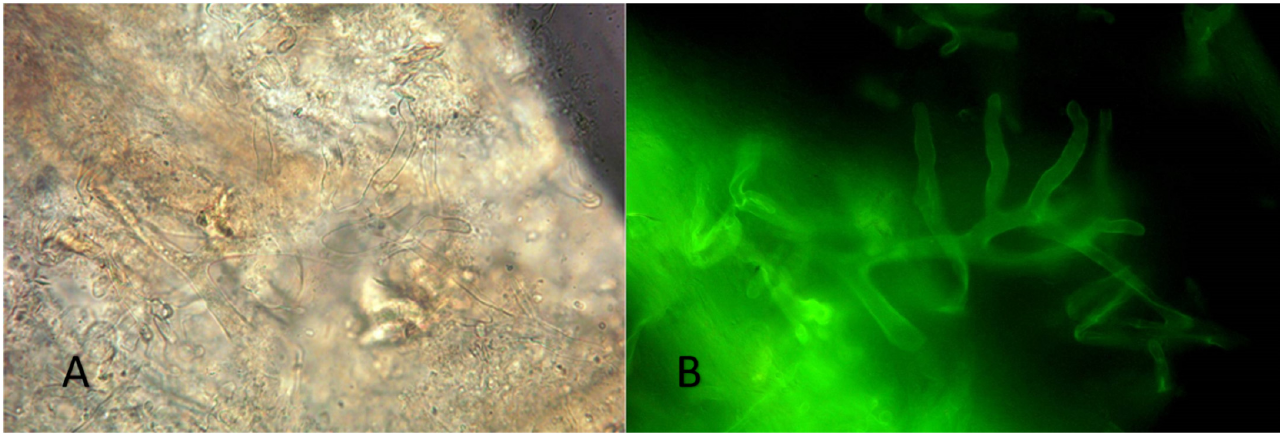
Figure 1. Skin necrotic lesion, located at the anterior tibia, arising from the surgical wound ( A ) ten days after external fixation of the open complicated tibia fracture and ( B ) thirty days after the initial surgical debridement.